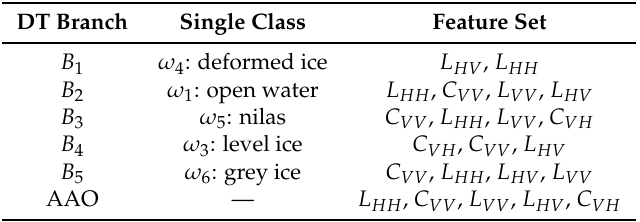
Table 5. Single classes and selected features for each branch of the numerically optimized DT for ICESAR